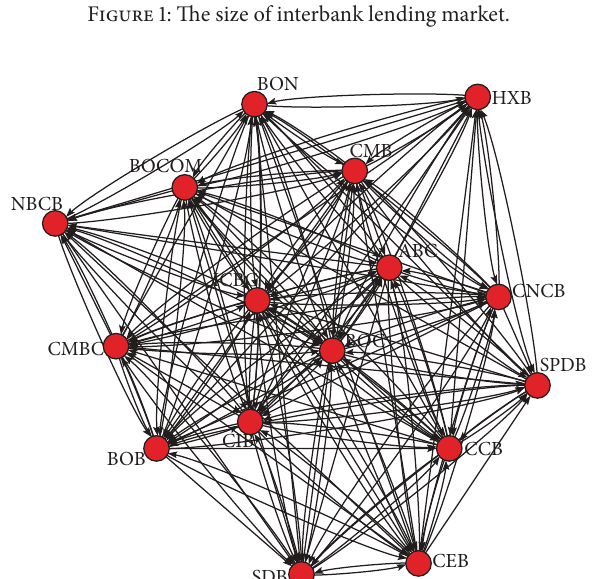
Figure 2: The network structure of the Chinese interbank market in